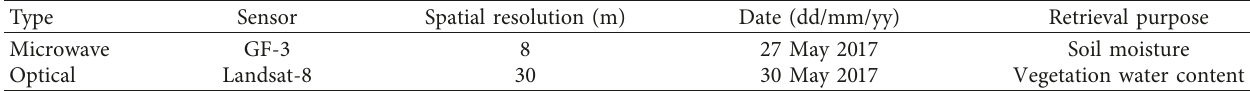
Figure 1: Left image shows the geolocation of the Luancheng study area in Shijiazhuang city, and the right image is Gaofen-3 (GF-3) Quad- Polarization Strip I (QPSI) data acquired on 27 May 2017. The red patches are residential areas, and the green triangles indicate the field measurement sampling points (point separation: 150m) in each field. Table 1: Satellite data characteristics used in this study.